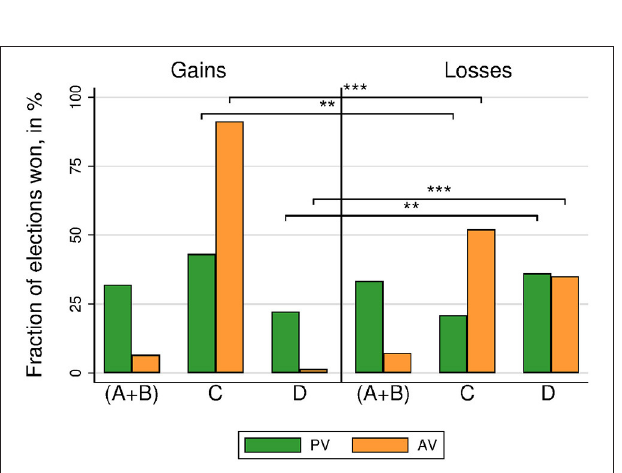
FIGURE 4 | Society 2. Left: voter support for the different alternatives by treatment (gains vs. losses), voting method (PV and AV), and voter group (EW and EL). A and B are the self-interested alternative players of types I and II, respectively. Alternative C assigns equal payoffs to all voters, and D is a socially-efficient alternative. Stars refer to the significance of non-parametric tests ( ∗∗ p < 0.01 ∗∗∗ p <